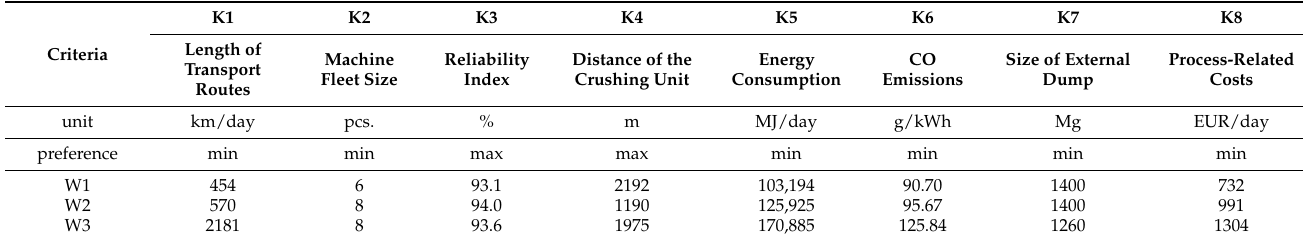
Table 3. Values of the specified common family of criteria (criteria evaluation matrix)—final values of the criteria for each analyzed variant (mining machines and systems). The values of the relative weights of the criteria, accepted in accordance with the preferences of the decision-maker, are presented in Table 8. Table 8. Relative and average importance of the criteria considered by experts